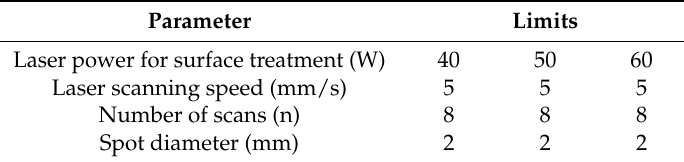
Table 4. Process parameters and limits for laser surface